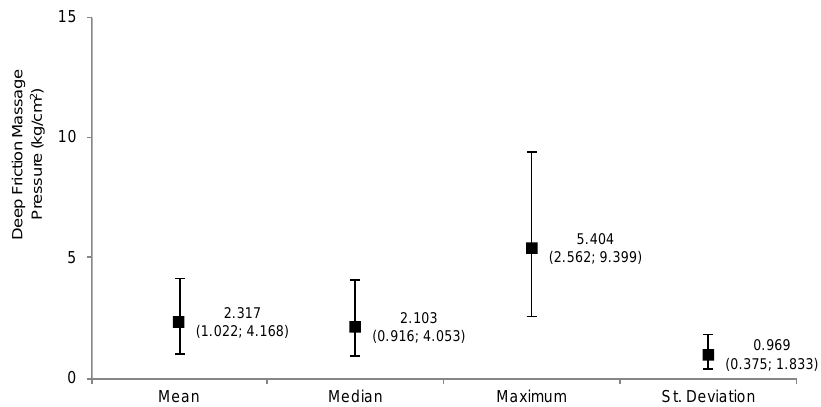
Figure 3. Median (P25; P75) of deep friction massage pressure parameters.